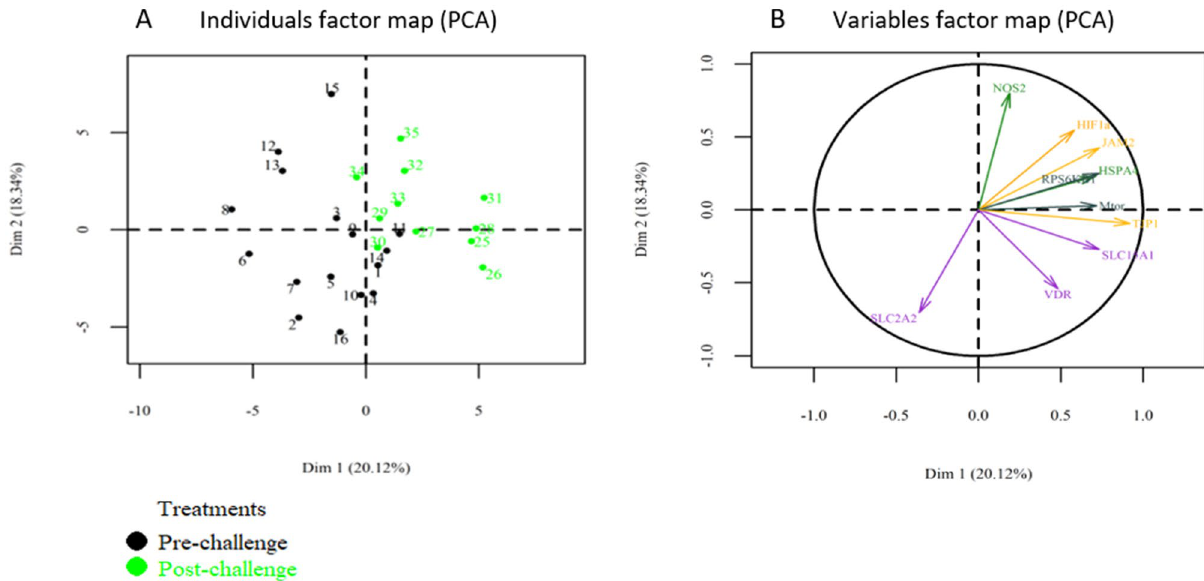
Figure 3. PCA representations of intestinal gene expression data in ileum chicken broiler samples ( A ) The samples dot plot; ( B ) variables arrow